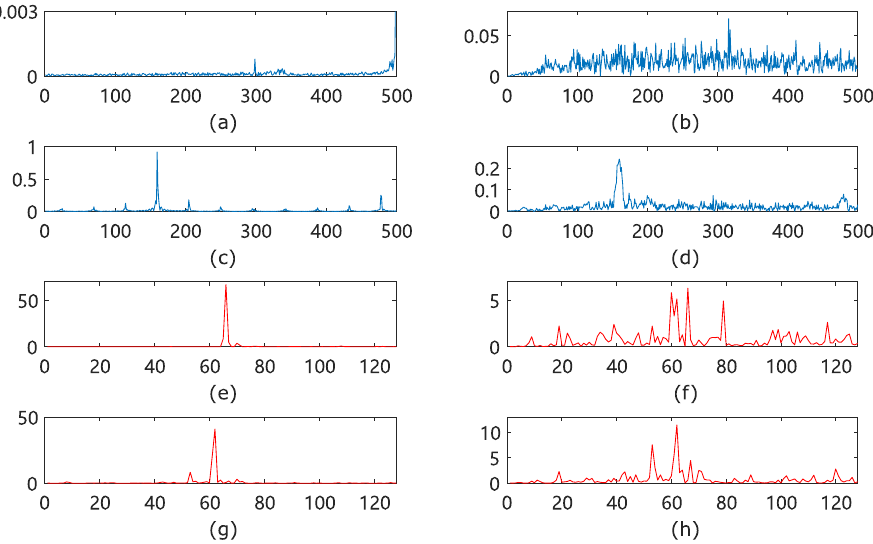
Figure 12. Preprocessing of fault data. ( a ) FFT of normal data. ( b ) FFT of normal data with vibration. ( c ) FFT of periodic interference fault. ( d ) FFT of periodic interference fault with vibration. ( e ) WPD of normal data. ( f ) WPD of normal data with vibration. ( g ) WPD of periodic interference fault. ( h ) WPD of periodic interference fault with vibration.